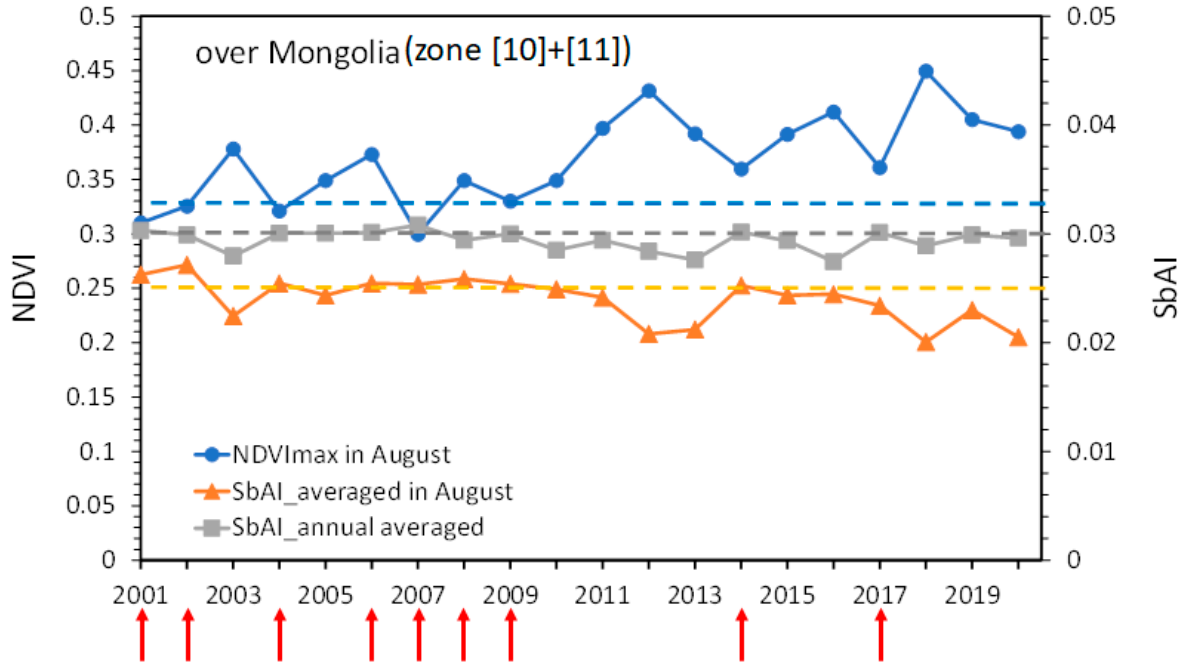
Figure 11. Annual changes (2001–2020) in the NDVI max in August, averaged SbAI in August, and annual averaged SbAI over Mongolia. Red arrows indicate drought years.